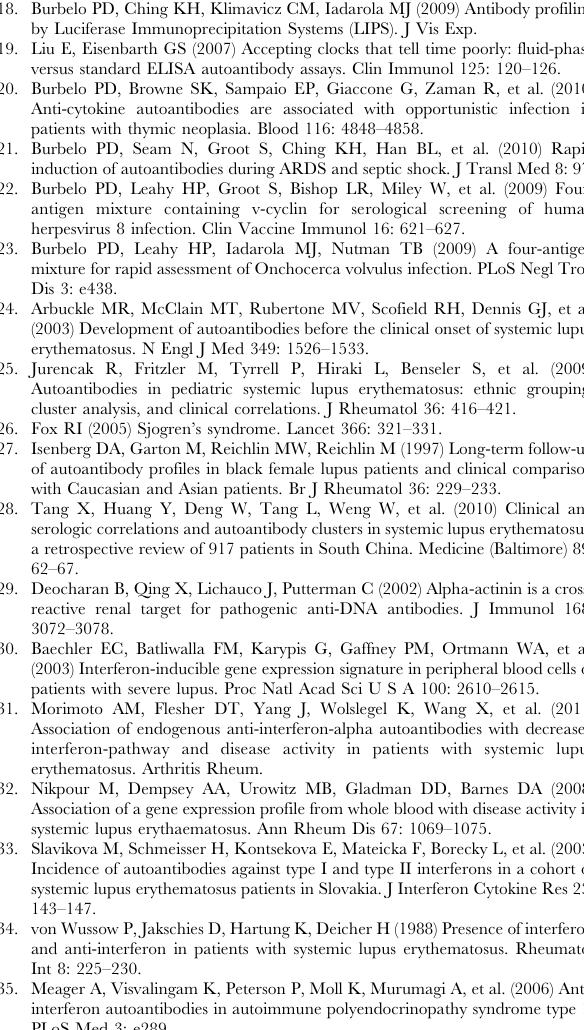
antigen fusion proteins produced from transfected COS1 cells. Table S1 Forward and reverse primers used for cloning of antigens used in this